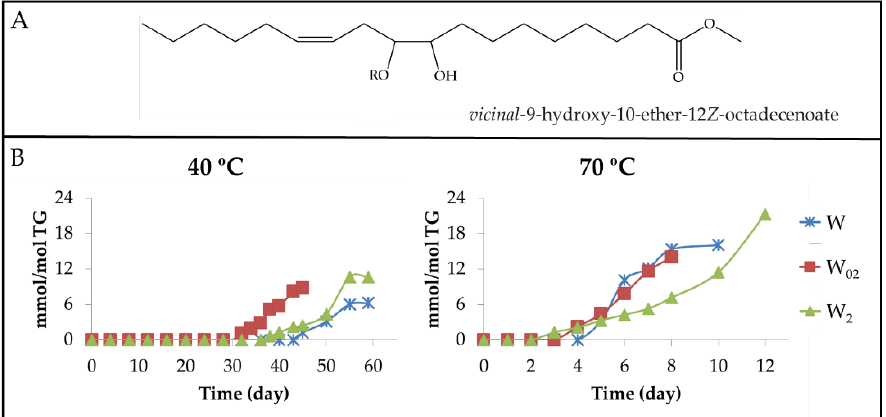
Figure 21. ( A ) Structure of an example of vicinal mEt-mHO derivatives. ( B ) Evolution of the concentration of protons generating the signal at 3.62 ppm attributable to methine protons of ether bonds and of secondary alcohols expressed as mmol/mol TG in walnut oil samples with different enrichment levels in αT (W, W 02 and W 2 ), submitted to either 40 °C or 70 °C up to advanced stages of the oxidation process.